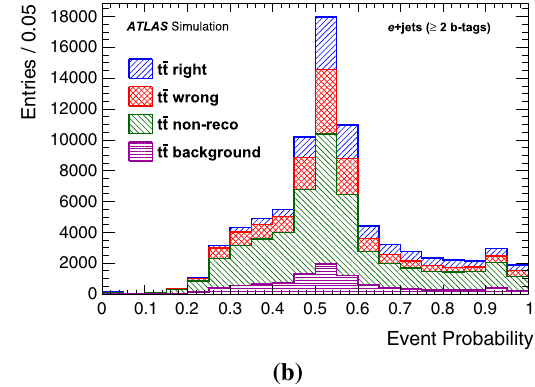
t ¯ t signal sample are split into events where the t ¯ t pairs do not decay via thelepton+jetschannel (“ t ¯ t background”), events where not all t ¯ t decay products have been reconstructed (“ t ¯ t non-reco”), as well as correctly (“ t ¯ t right”) and incorrectly (“ t ¯ t wrong”) reconstructed t ¯ t